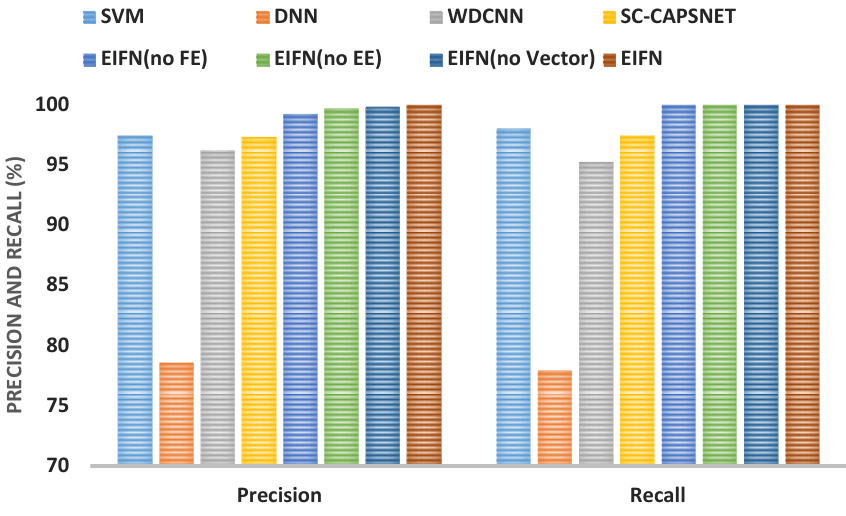
Figure 10. The result of bearing fault diagnosis on IMS. The figure contains two indicators: precision and recall.